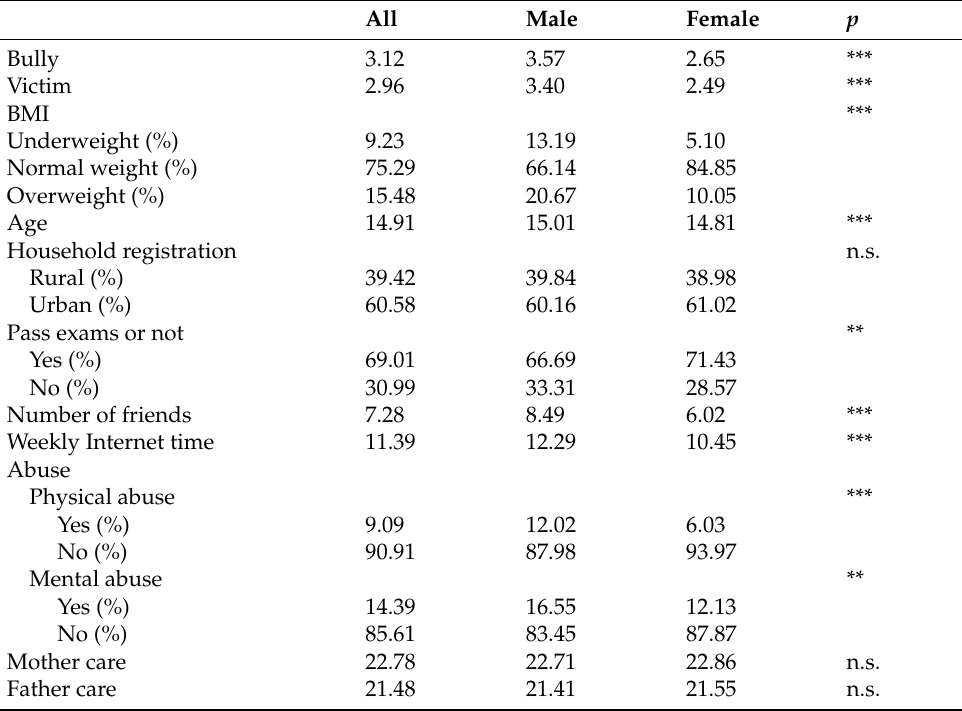
Table 1. Descriptive Statistics for Male ( n = 1456) and Female ( n = 1393).